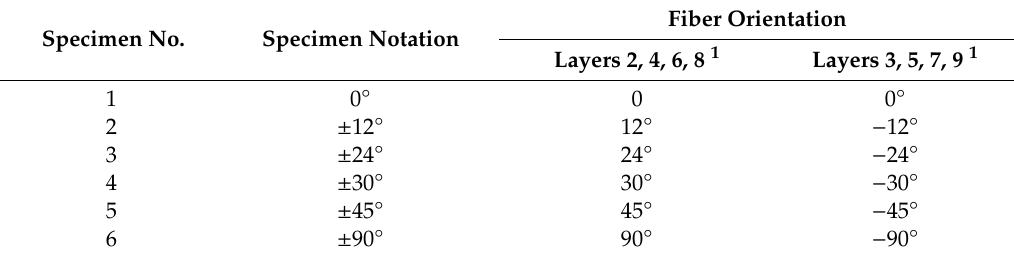
Table 1. 3D-printing sequence in the single-angled 3D-printed glass fiber reinforced polymer (GFRP) composites (Set 1).